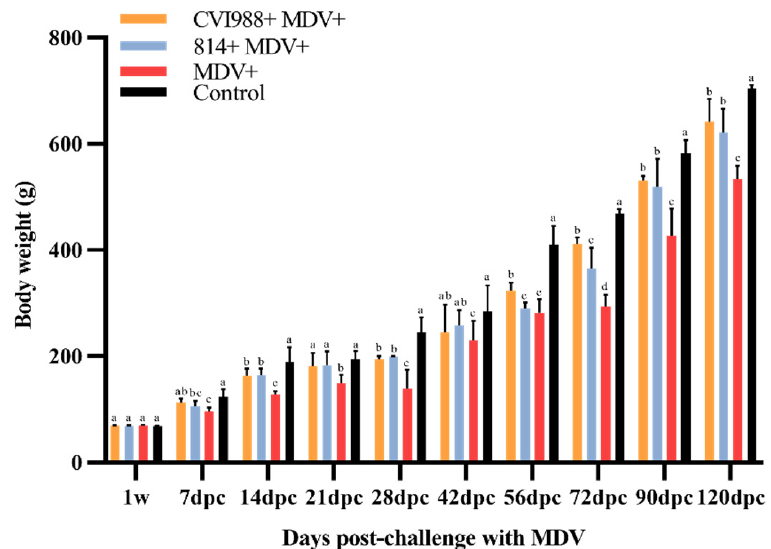
Figure 1. Statistics of body weight of experimental birds (X ± SD). Means not sharing a common letter are significantly different ( p < 0.05).